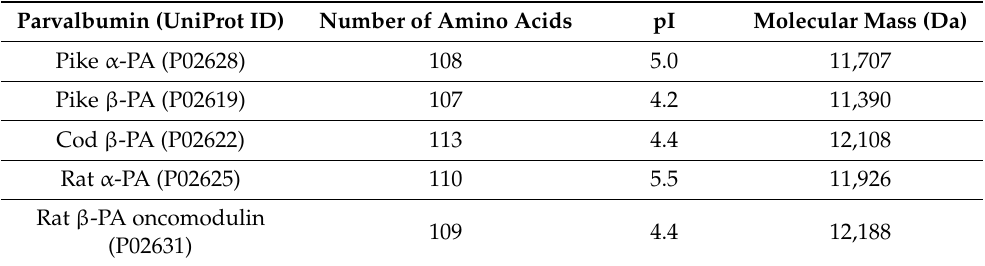
Table 1. Number of amino acid residues, pI values, and molecular masses of some parvalbumins (corresponding data are derived from the UniProt database).